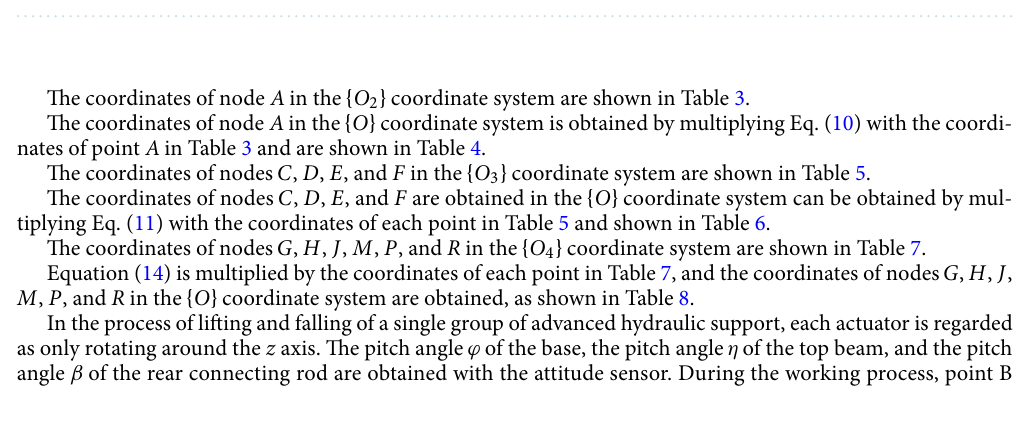
Table 6. Coordinates of nodes C , D , E , and F in the { O } coordinate